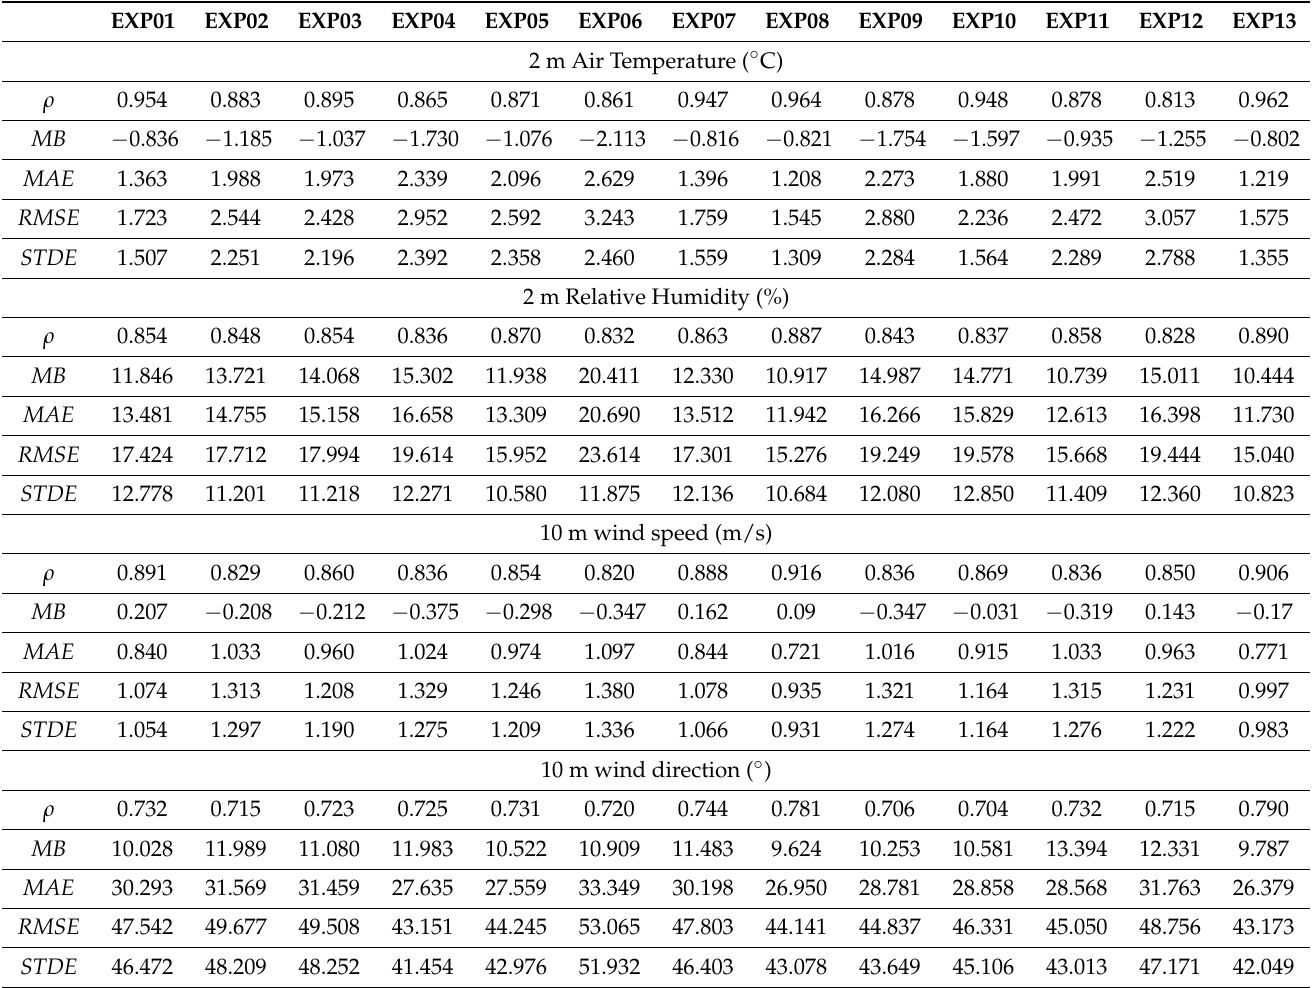
Table 4. Statistical metrics calculated for June 2019 hourly data at Barakah